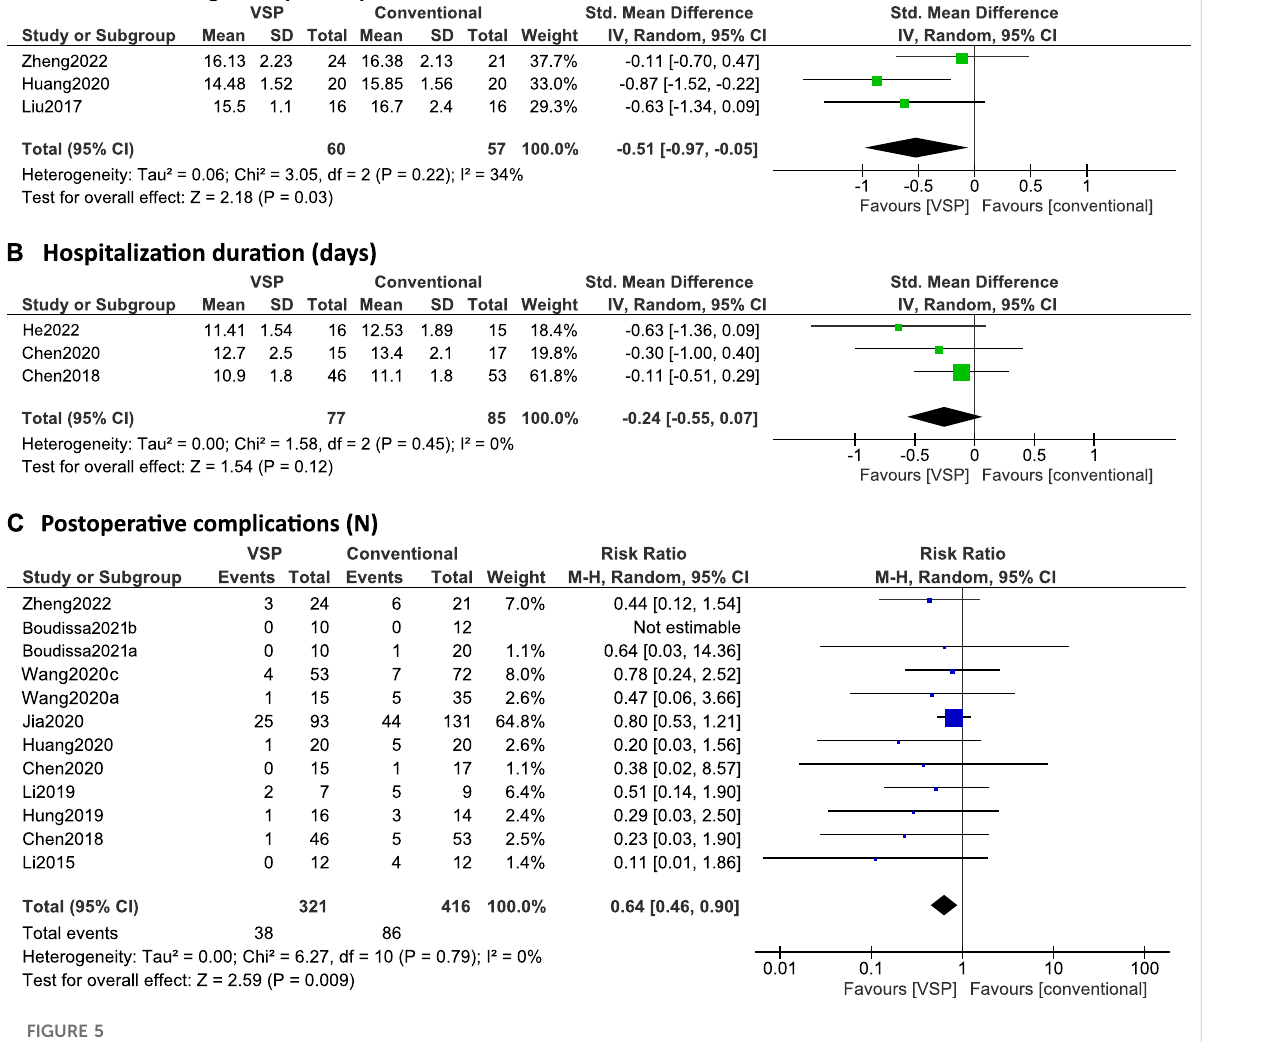
FIGURE 5 (A – C) : Forest plots of postoperative clinical outcomes. Green/blue boxes + horizontal lines: standardized mean differences (A/C) or risk ratios (B) as reported by the individual studies along with 95% con fi dence intervals, size of the box represents the weight of the individual studies. Diamonds: combined standardized mean difference (A/C) or risk ratio (B) with the outer edges representing the 95% con fi dence interval. Total: number of patients. (A) Fracture healing time (weeks), (B) Hospitalization duration (days), (C) Postoperative complications